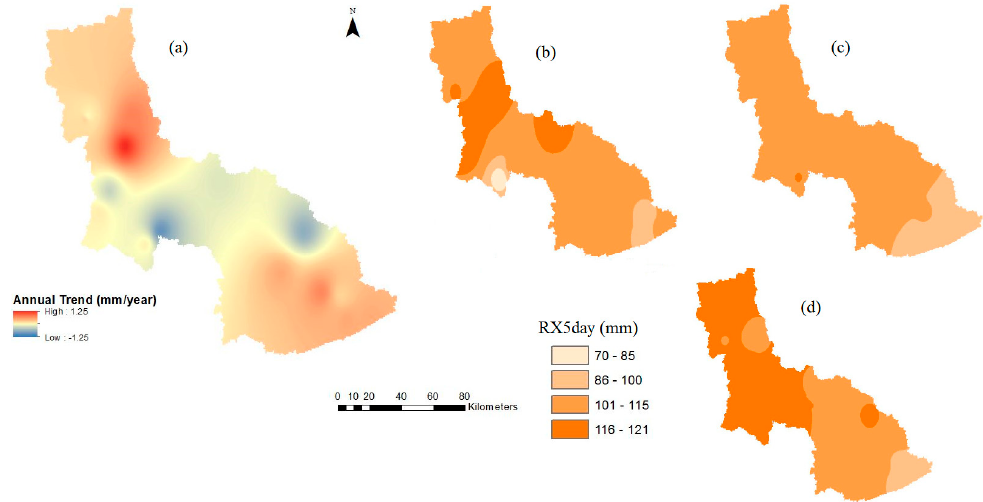
Figure 9. Spatial distribution of RX5day ( a ) trend and mean values under: ( b ) baseline; ( c ) late ‐ century RCP 4.5; and ( d ) late ‐ century RCP 8.5, in the Kentucky River Basin.